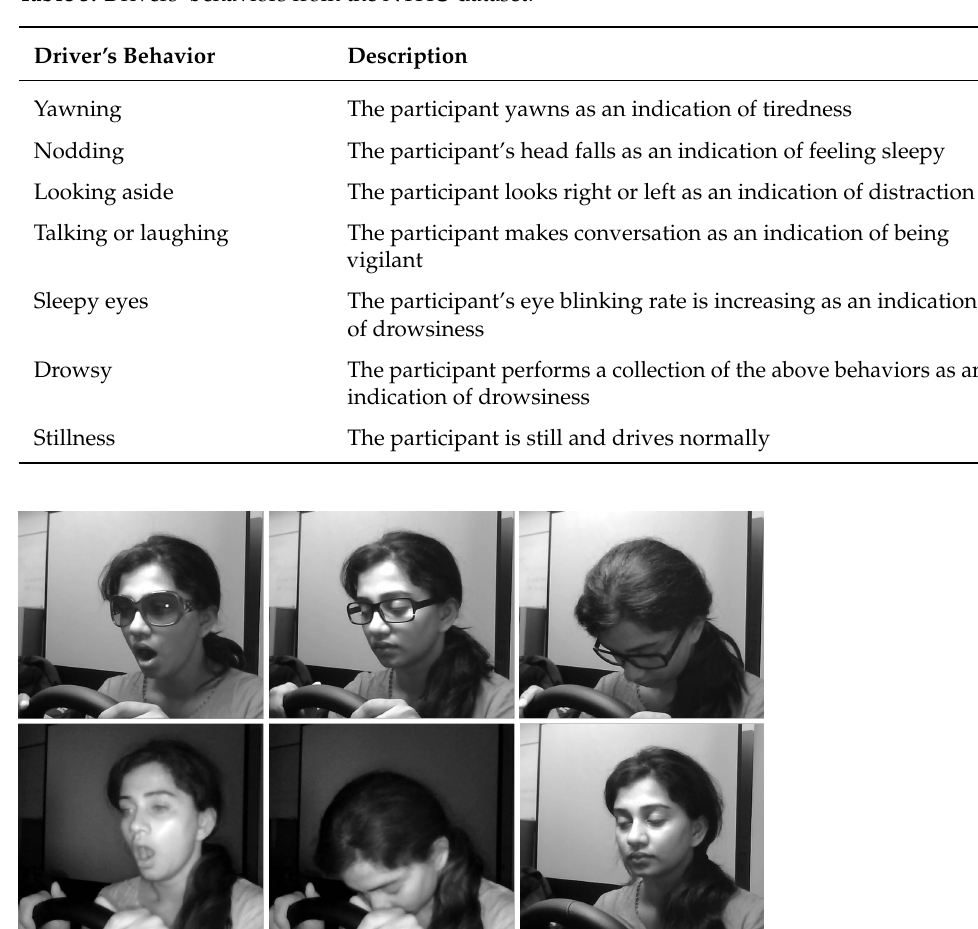
Table 3. Drivers’ behaviors from the NTHU dataset.